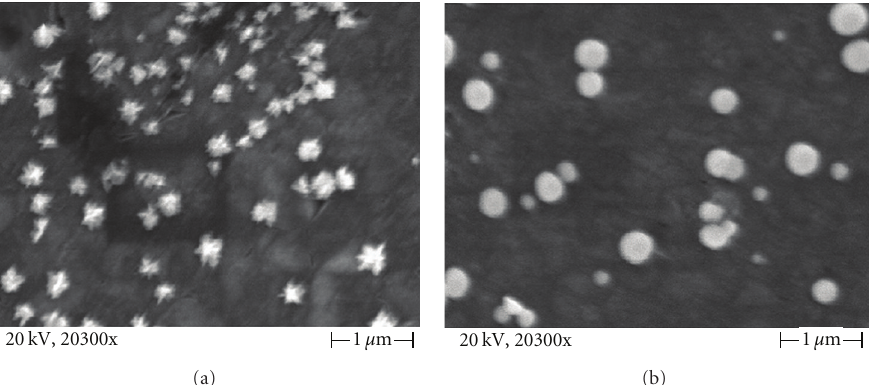
Figure 7: SEM images of Pt-Ru deposited on BDD electrode at − 0.2V for 10min, (a) sequential deposition, and (b) simultaneous deposition (reprinted with permission from [45]).